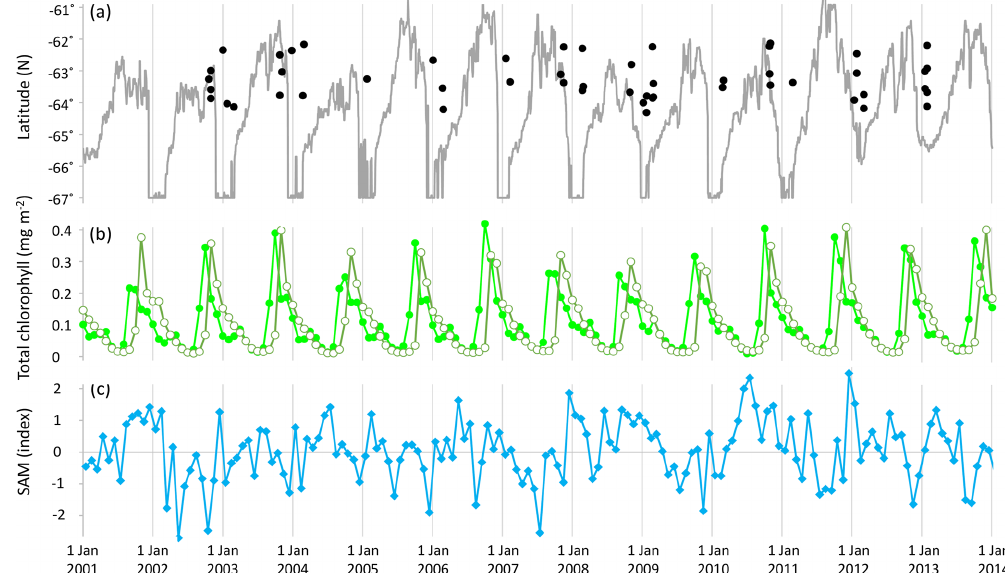
Figure 1. (a) Latitude and timing of samples (black filled circles) and sea ice extent at 143 ◦ E (grey solid line); (b) monthly total chlorophyll (Acker and Leptoukh, 2007; GMAO, 2017) across the sampled area (longitude 135.7–147.8 ◦ E): northern extent (latitude − 62 ◦ N, light green solid circles) and southern extent (latitude − 64.5 ◦ N, olive-green open circles); and (c) monthly average of daily SAM (NOAA, 2017).